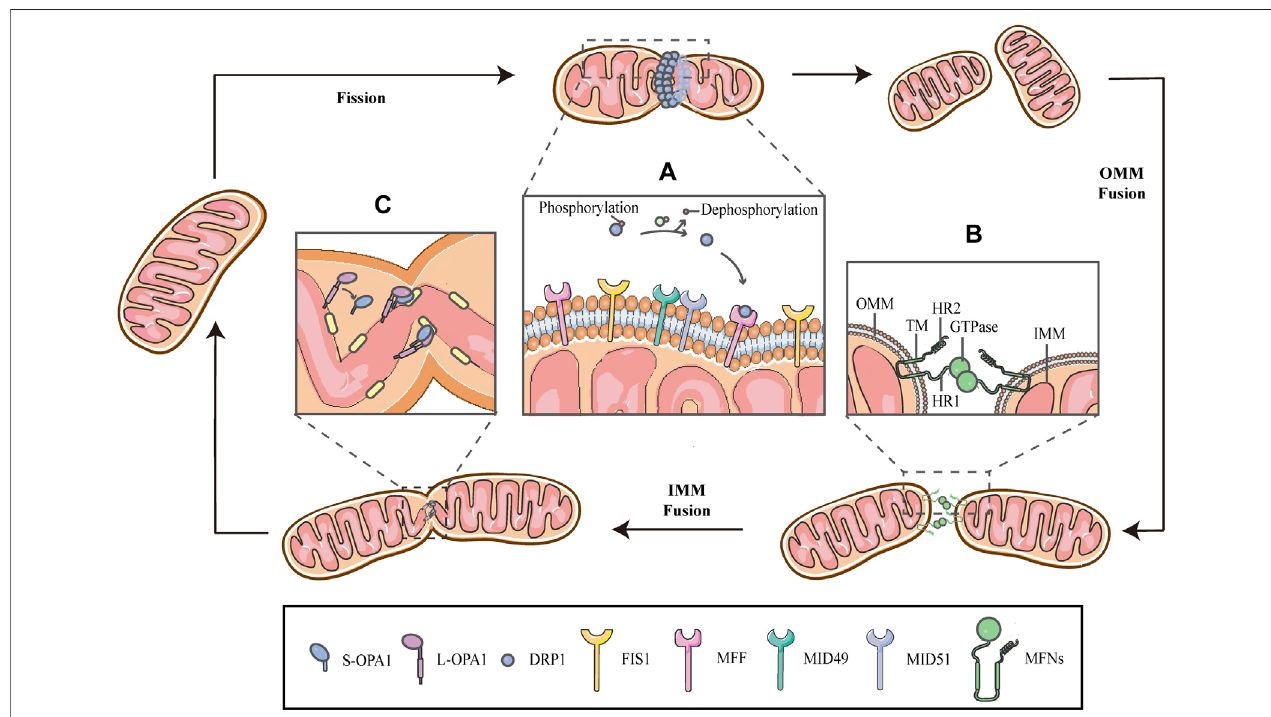
FIGURE 1 | Schematic diagrams of mitochondrial fi ssion-fusion cycles. Mitochondria constantly undergo fi ssion and fusion cycles to maintain a characteristic morphology in dynamic balance, allowing the mitochondrial network to adapt to cellular demands and immediately respond to imposed stresses. (A) Mitochondrial fi ssion is mainly executed by DRP1, which is phosphorylated on Ser637, keeping it in the cytosol. When fi ssion occurs, the cytosolic DRP1 is dephosphorylated by calcineurinandrecruitedtotheOMMthroughinteractionswiththecorrespondingreceptors,includingMFF,FIS1andMiD49/51,andthenDRP1self-assemblesto form aringlike structureand induces GTPhydrolysis tomediatemembrane constriction. (B) Mitochondrial fusion begins with the OMM fusion, which iscontrolled by the MFNs. The MFNs isinserted into the OMM via two TM domains, separated by ashort loop, exposing the HR2 domain and the GTPase with HR1 domain, both of which face the cytoplasm. The speci fi c trans-structure underlies MFNs-mediated OMM fusion. (C) Following OMM fusion, the interaction between L-OPA1 and CL drives the fusion of IMM. The interaction is enhanced in the presence of S-OPA1, which is generated by proteolytic cleavage of L-OPA1.